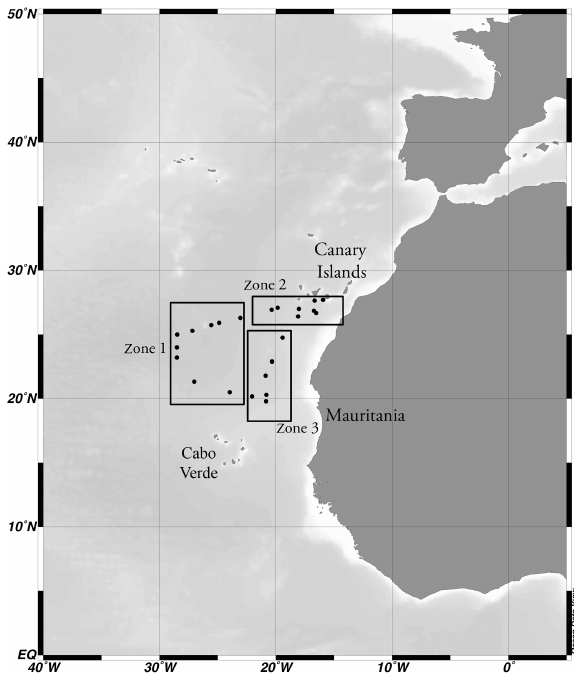
Figure 1. Areas of sampling and stations occupied during the RODA cruise. Zones 1, 2, and 3 correspond to three singular hydro- graphical and biological conditions: oligotrophic tropical Atlantic zone (Zone 1); intermediate Gran Canaria Current area (Zone 2); upwelling associated waters (Zone